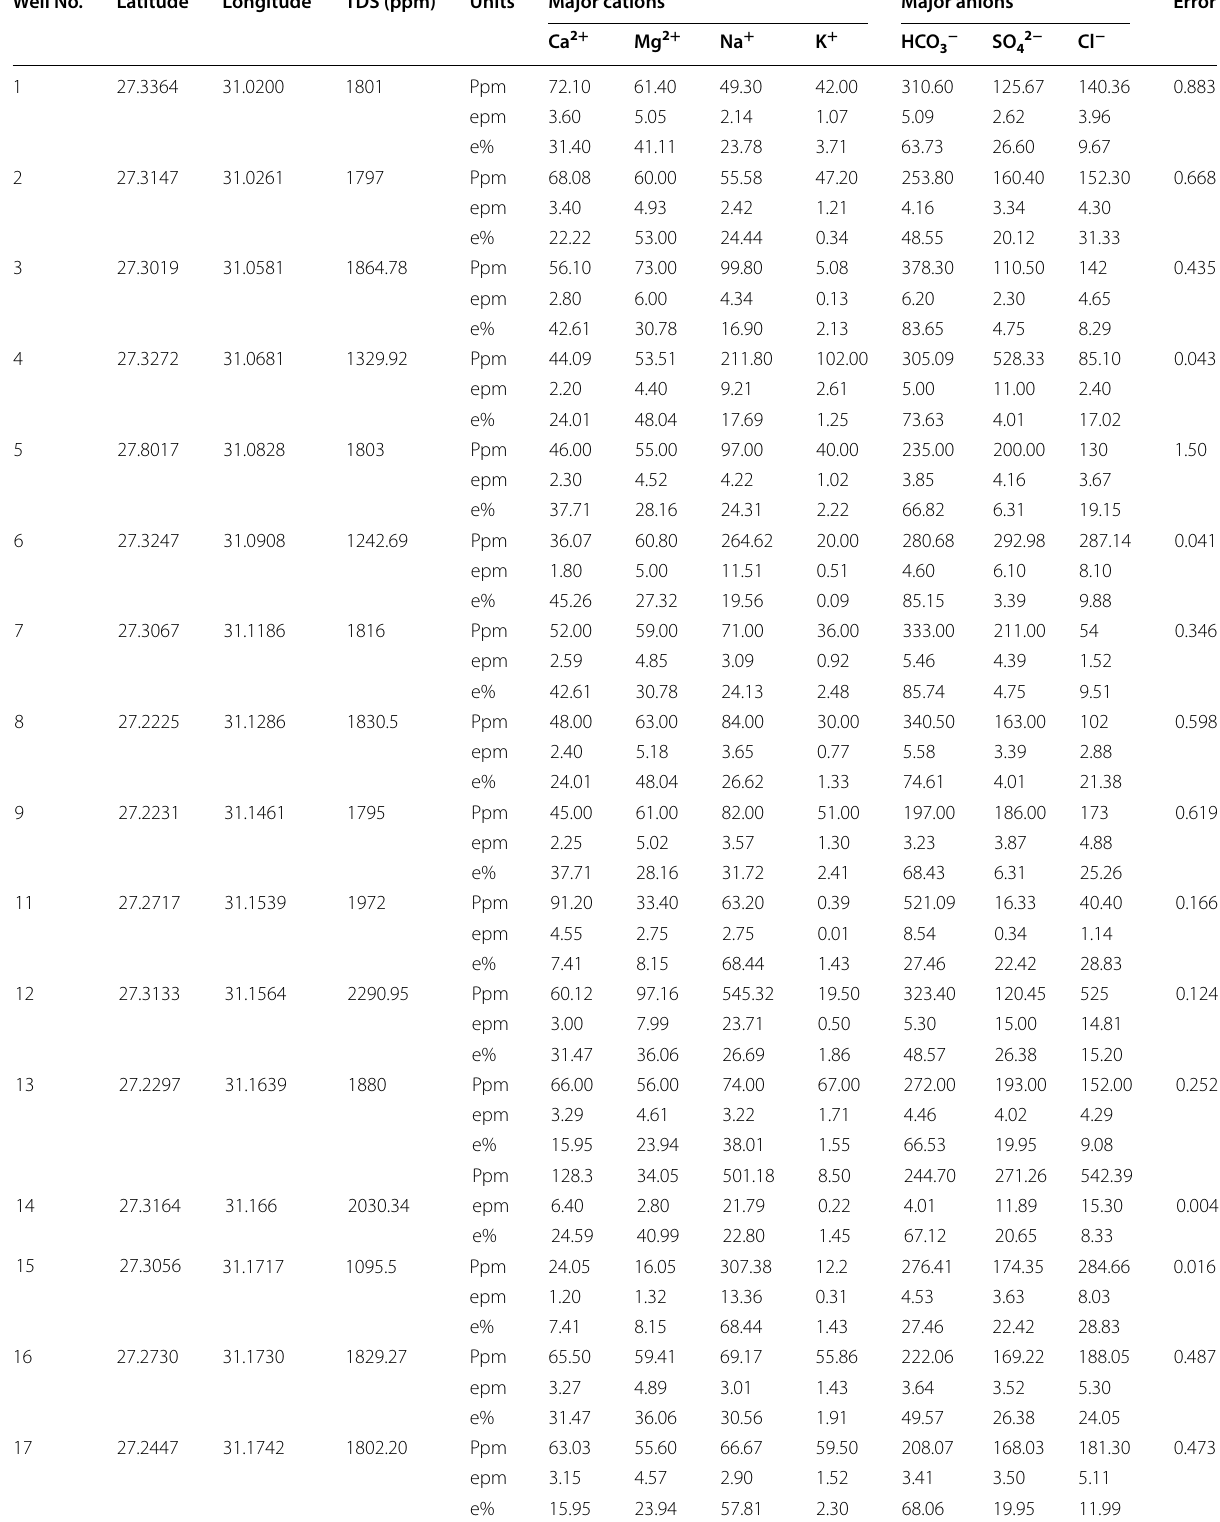
Table 2 Results of chemical analyses of groundwater samples in the study area Well